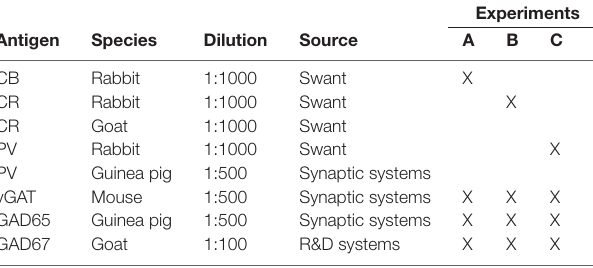
TABLE 1 | Antibodies and immunohistochemistry experiments.